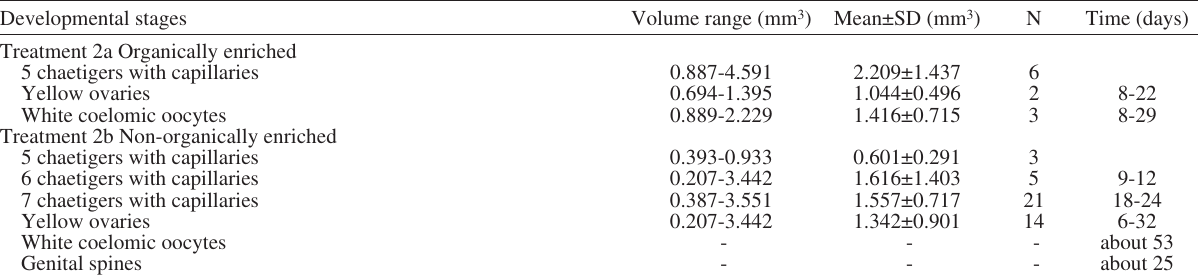
Table 2. – Volumes of immature adults selected from the stock cultures of the experimental series 2 and time elapsed from the stage of five chaetigers with capillaries. Developmental